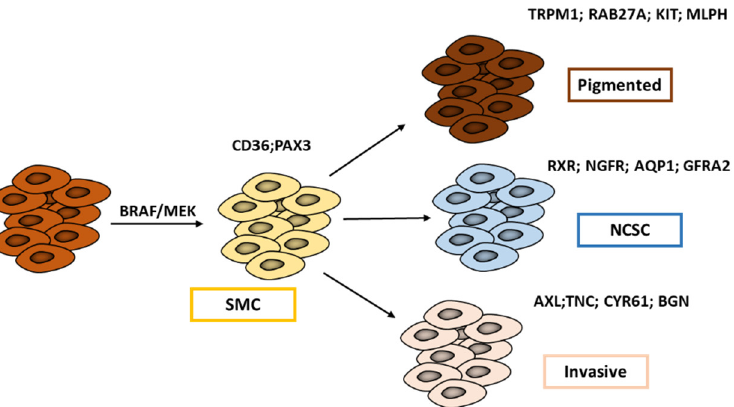
Figure 2. Melanoma cell states associated with minimal residual disease (MRD). Exposure to MAPK inhibitors promotes a phenotypic switch from the melanocytic state towards a starved-like state (SMC) facilitating a transition towards either a pigmented/differentiated phenotype or to an undifferentiated one: the classical invasive state or the neural crest stem-like cell (NCSC) state (adapted from Rambow et al. 2018 [43]).